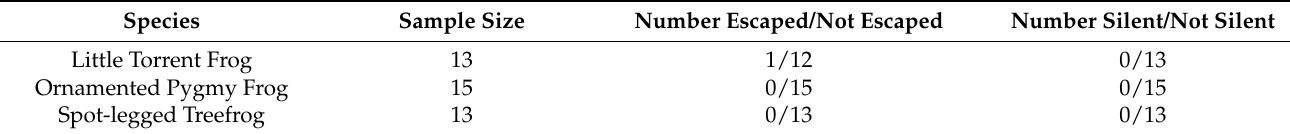
Figure 1. Spectrograms of four groups of Japanese Tit calls. ( a ) territory song; ( b ) alarm call evoked by the Siberian Chipmunk; ( c ) alarm call evoked by the Sparrow Hawk; ( d ) alarm call evoked by the snake. Table 1. Responses of three frog species to white noise playbacks.